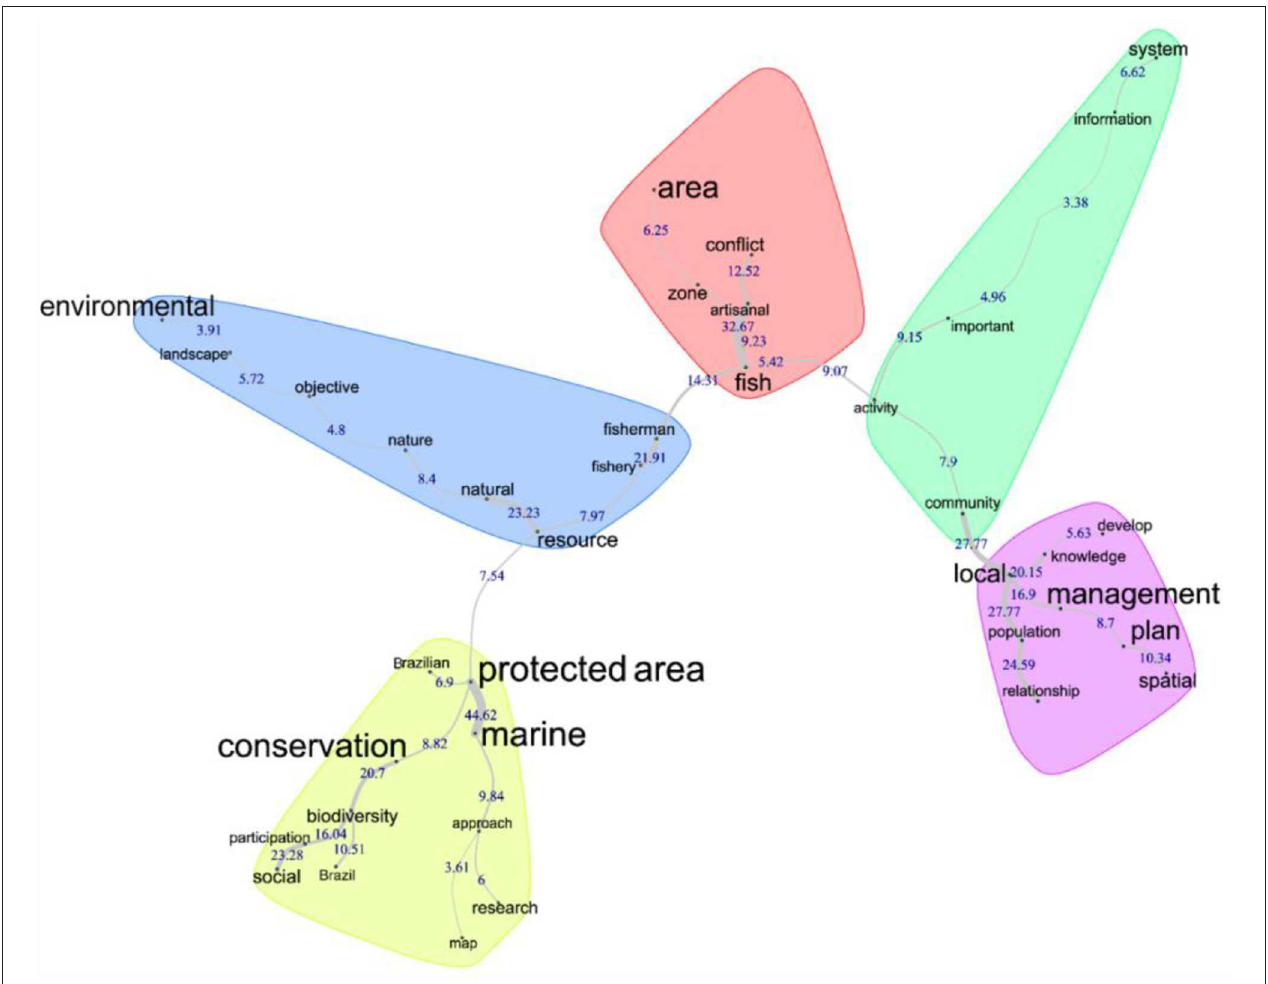
FIGURE 6 | Similarity analysis of studies in Brazil (local case study excluded). The numbers represent the proximity, expressed as the distance between the words based on frequency and similarity. The largest words are the most frequently mentioned. These words are interconnected by frequency, based on the theory of graphs and networks. The colors represent the classes, which were established according to the proximity of the words in the texts. This similarity analysis is related to the DHA in Figure 8